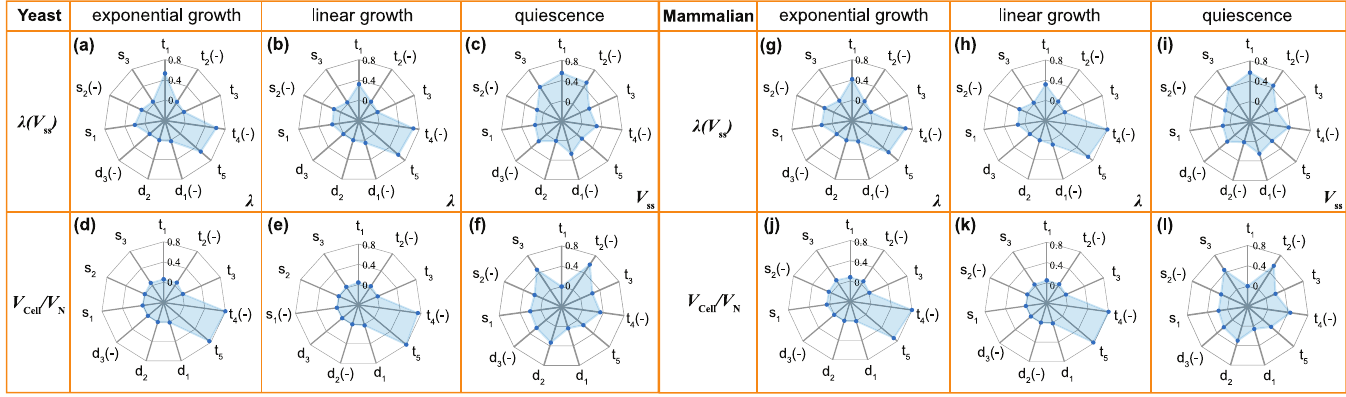
Fig 7. (a)-(f) Gradients of the cell growth rate and the C/N ratio with respect to the normalized model parameters for exponential, linear growth conditions, respectively. For the quiescent case, gradients of the steady state cell volume with respect to parameters are shown. Amino acid and non-ribosomal protein transport ( t 1 , t 4 , t 5 ) are most important parameters in exponential and linear growth conditions. For the quiescent case, ribosomal protein transport ( t 2 ) and ribosome synthesis ( s 3 ) play most important roles. (g)-(l) Corresponding results for mammalian cell. All parameters are listed in Table 2.